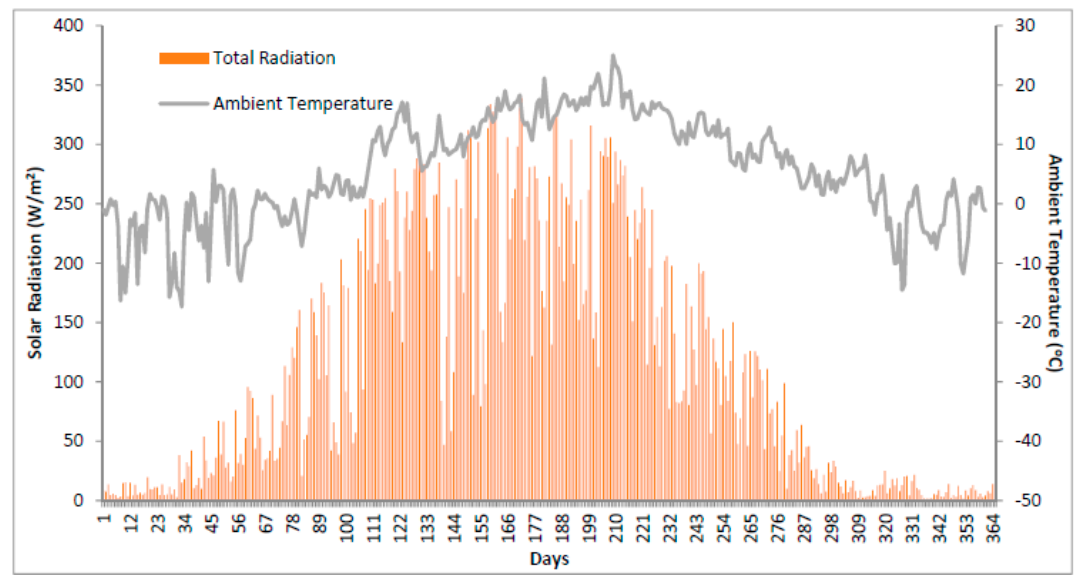
Figure 6. The daily average ambient temperature and solar radiation in the Southern Finland region.